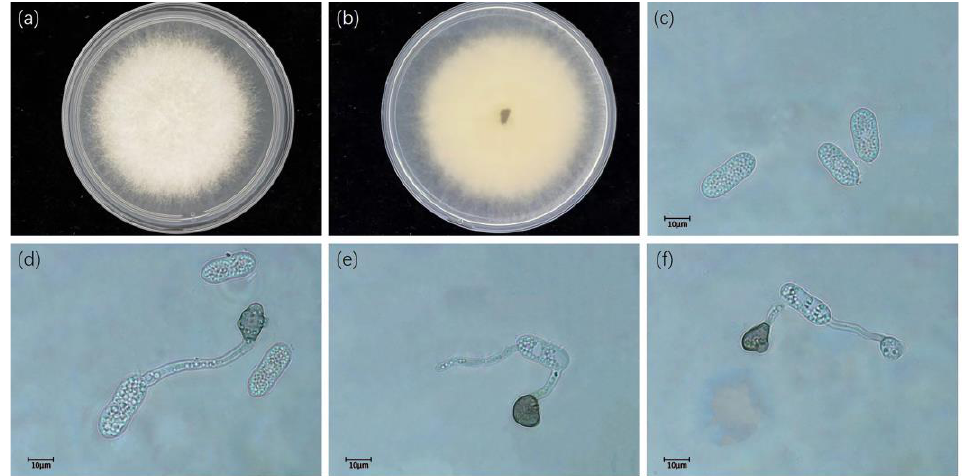
Figure 7. Colletotrichum aeschynomenes (GXNN4-1). ( a ) Colony on PDA. ( b ) Reverse side of the colony on PDA. ( c ) Conidia. ( d – f ) Appressoria. Scale bars = 10 µm.